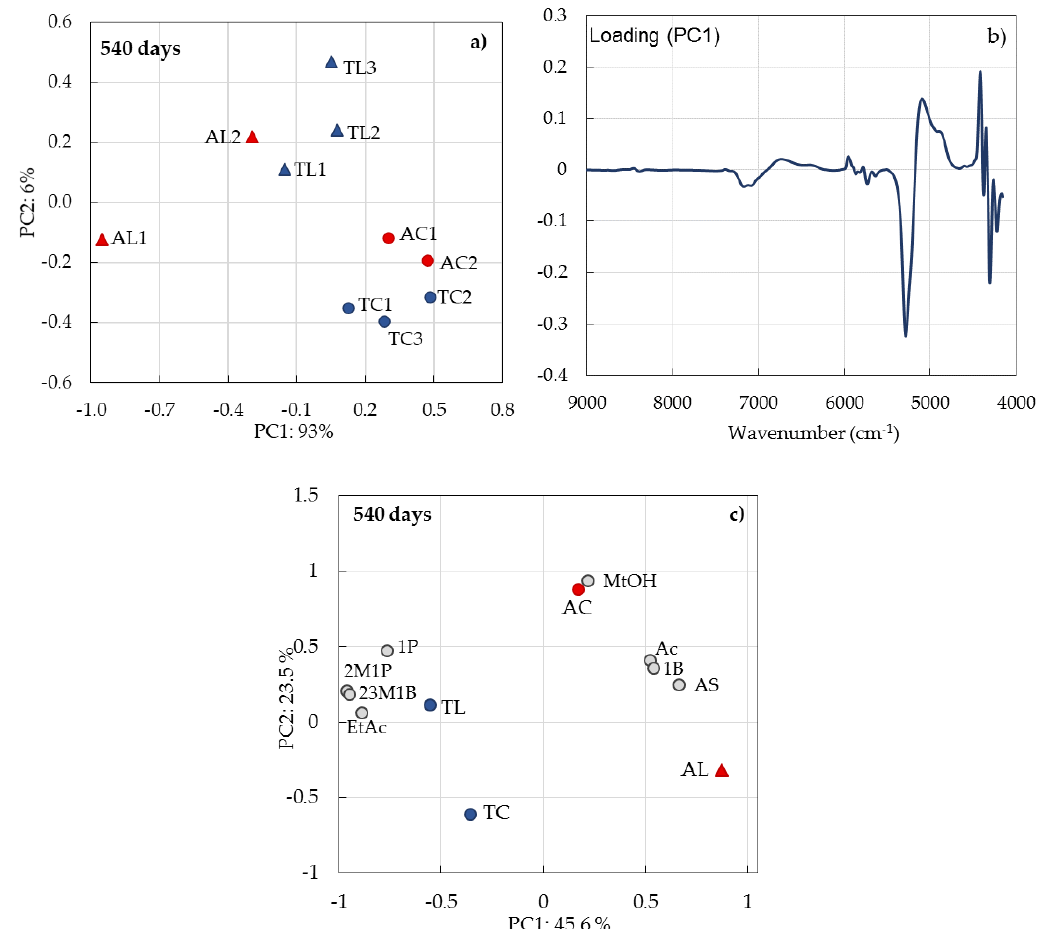
Figure 6. Principal component analysis of wine spirits aged in traditional and alternative technologies in chestnut and oak wood aged for 540 days for: ( a ) scores of NIR spectral information; ( b ) loadings of NIR spectral information; ( c ) standardised scores and loadings of analytical parameters